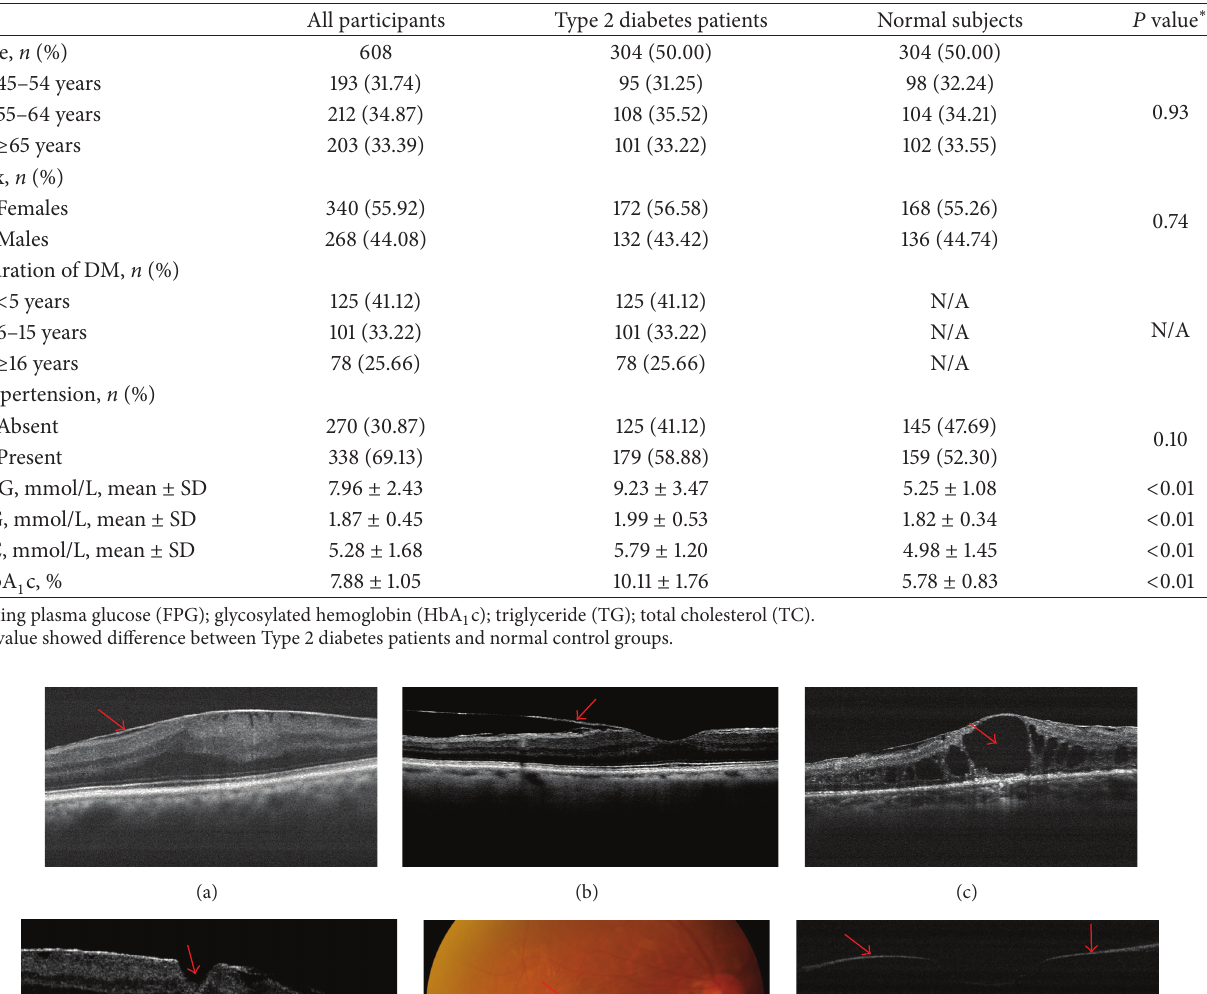
Table 2: Characteristics for all subjects.